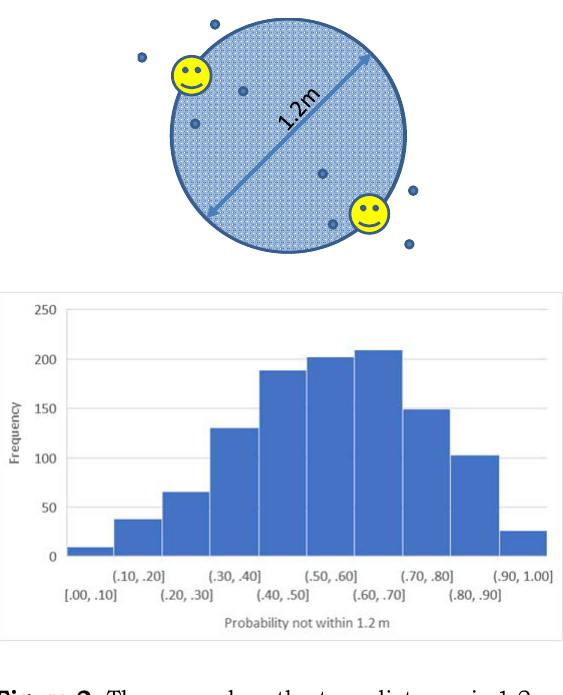
Figure 2. The case when the true distance is 1.2 m Note: The smiley mark is the real place. The dots around the smiley mark indicate variations in